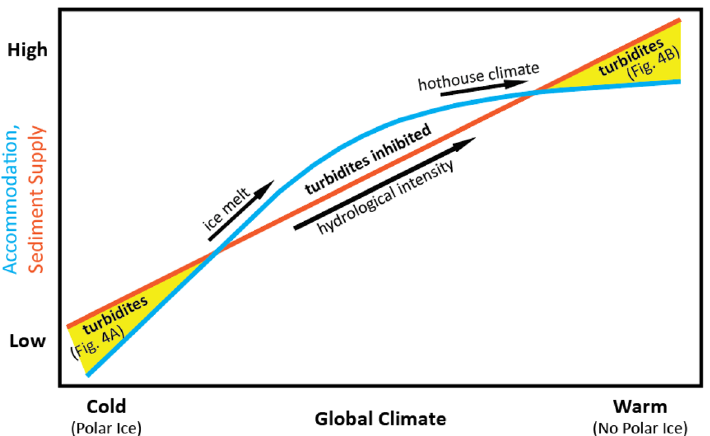
Figure 3. Conceptual model of passive margin sandy turbidite deposition related to climate controls on sediment supply (orange line) and accommodation (blue curve). Sediment supply increases with global temperature via its role in intensifying precipitation. Accommodation increases rapidly with initial warming as ice melts and sea level rises. Later warming (after ice melt) has a much weaker effect on sea level and accommodation. Sand-rich deposition (yellow areas) happens when sediment supply exceeds accommodation for a given climate